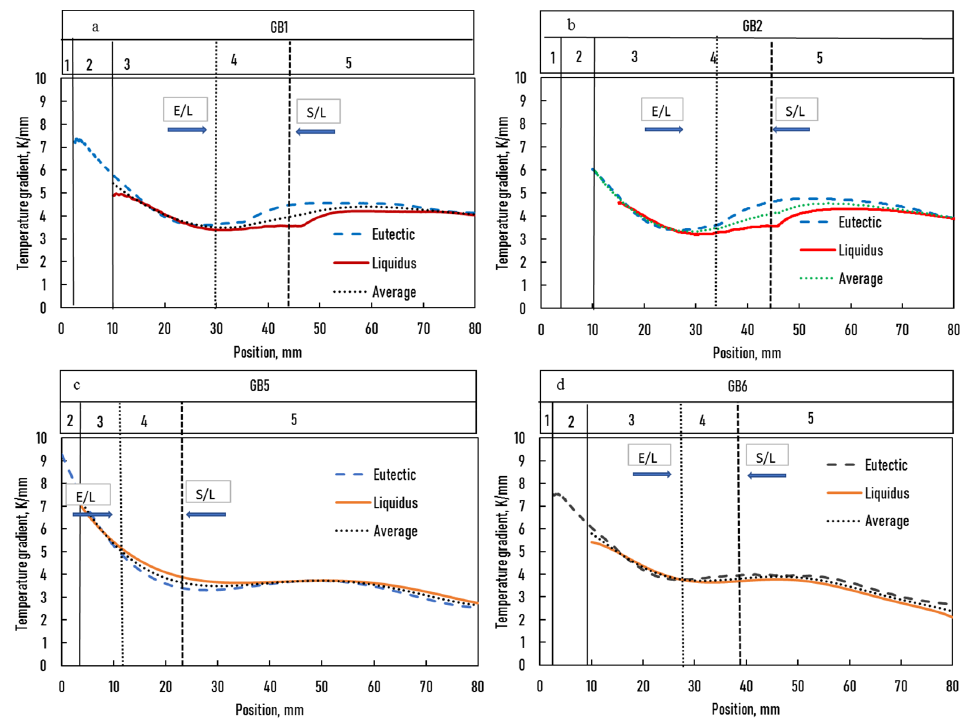
Figure 5. Temperature gradient at the S/L and E/L fronts vs. position of four samples ( a ): GB1, ( b ): GB2, ( c ): GB5, ( d ): GB6.